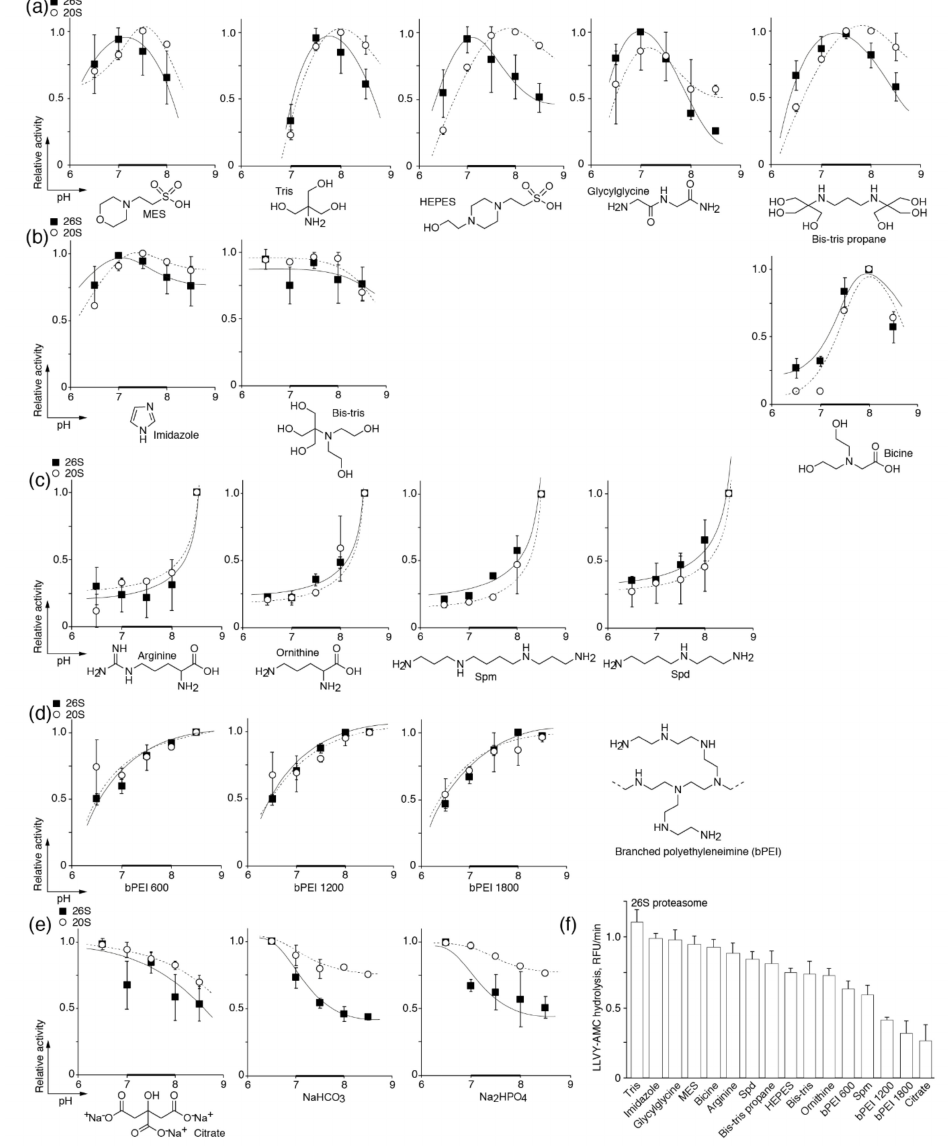
Figure 2. The pH dependence of the proteasomal chymotrypsin-like peptidase activity in different buffers containing (poly)amines ( a – d ) and anionic buffers ( e ). The skewed distribution ( a ), pH-independent ( b ), bursting ( c ) and progressive ( d ) types of activation are shown. Activity levels of the 26S ( (cid:4) ) and 20S ( proteasomesweremeasuredusingsuccinyl-Leu-Leu-Val-Tyr-7-amido-4-methylcoumarin(Suc-LLVY-AMC) at 25 mM of each buffer system. Relative activity was calculated as the ratio of activity at a distinct pH to the maximal activity within the tested pH range. ( f ) Absolute activity of the 26S proteasome in different buffers at the optimal pH value for each buffer system. The data represent the average and standard deviation (error bars) from four independent measurements. Natural polyamines (Spm, Spd) and branched polyamines (bPEI) were used at a concentration of 5 mM; all other buffers were at 25 mM. The data were fitted to a polynomial square of an exponential or Gauss function. The physiologically relevant pH range is shown by a bold